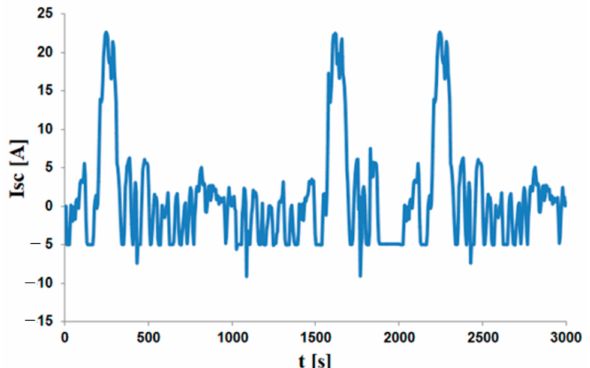
Figure 6. DC-current profile based on FTP-75 (US Federal Test Procedure 75).